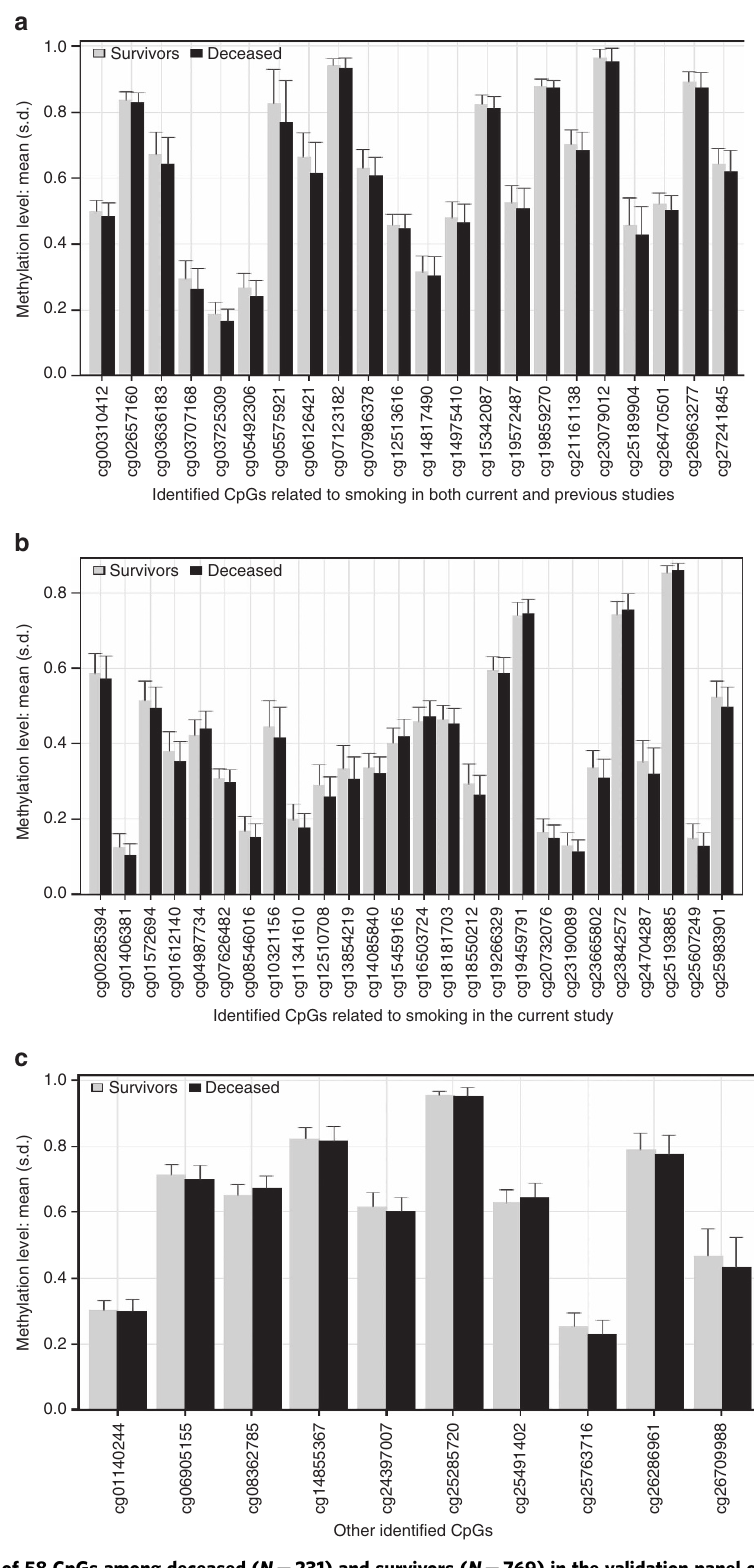
NATURE COMMUNICATIONS|8:14617|DOI: